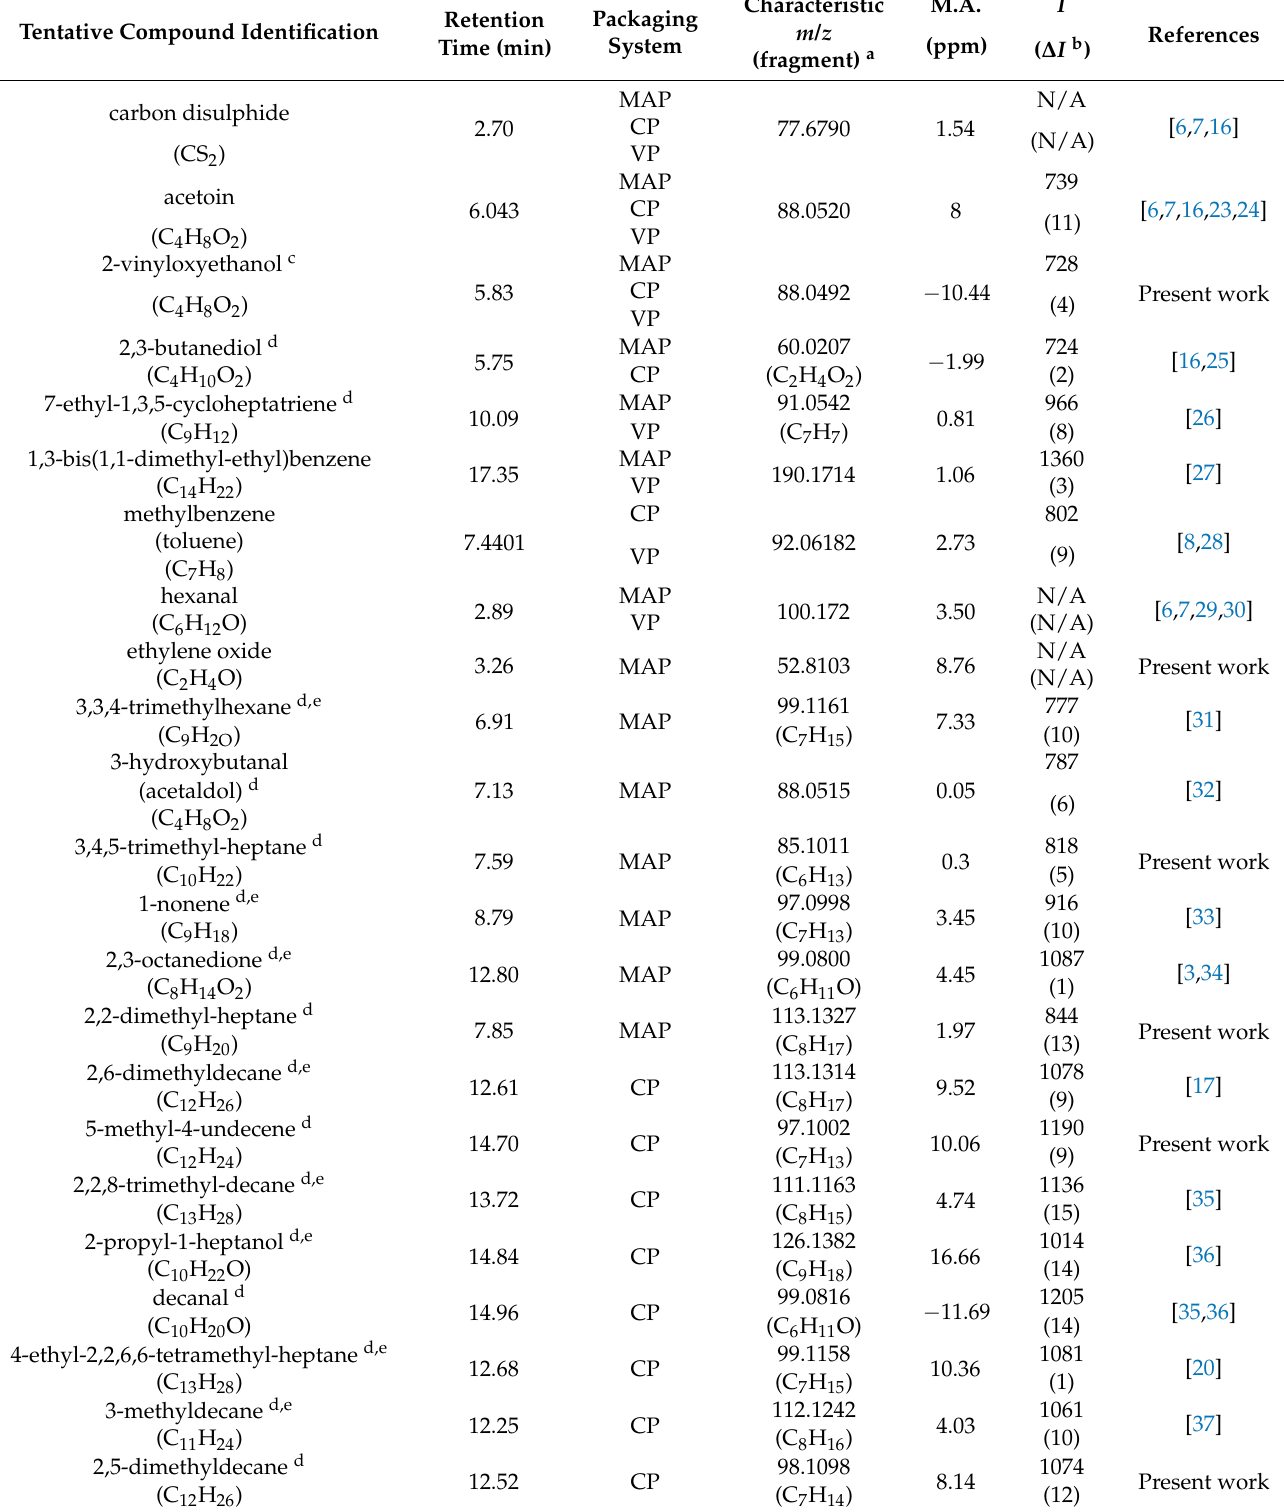
Table 1. VOCs of raw porterhouse steak samples from modified atmospheric packaging (MAP), cling-wrapped packaging (CP), and/or vacuum packaging (VP) identified using SPME-GC–accQTOFMS. Analytes are sorted by packaging systems and retention